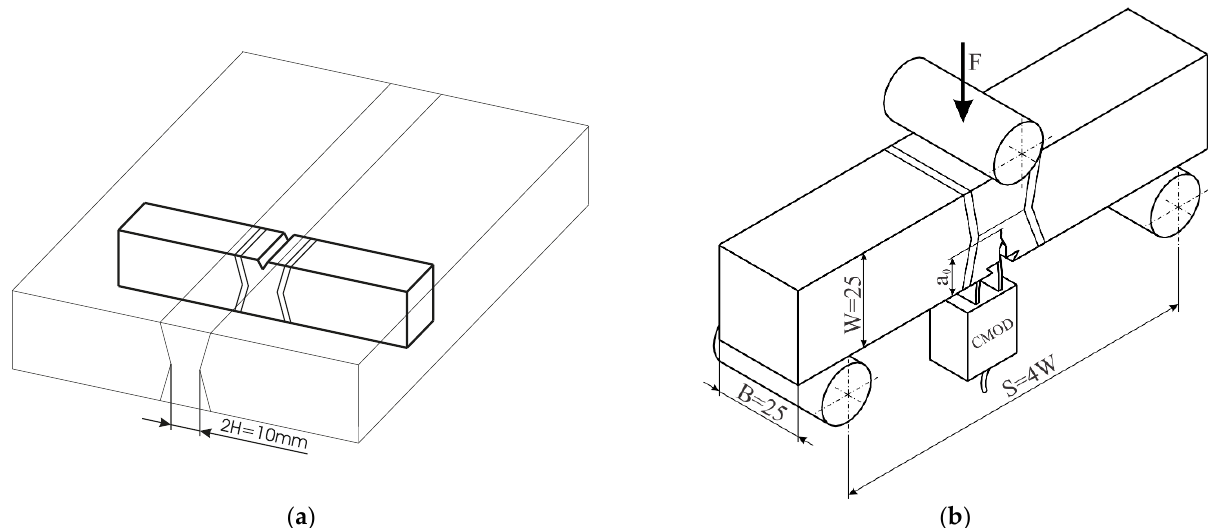
Figure 4. Schematic view of specimen orientation in a welded plate and testing manner: ( a ) specimen notch-crack orientation; ( b ) specimen for three point bending fracture toughness testing.